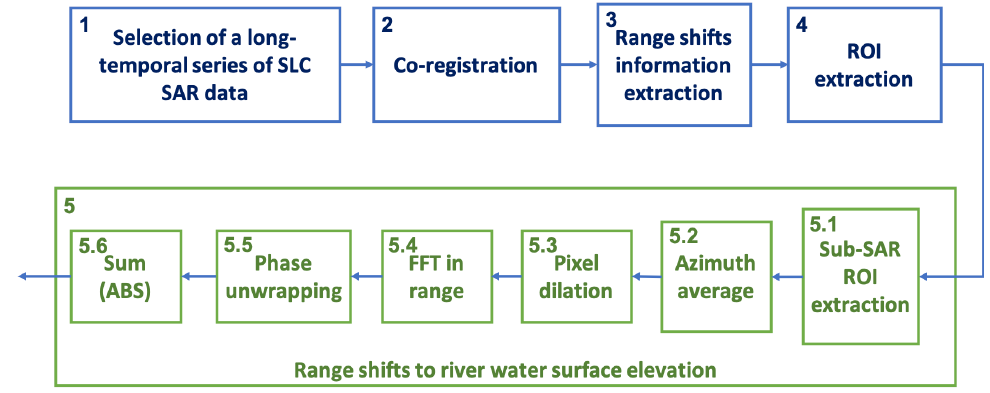
Figure 2. Flow chart of the main procedure to extract water level information from a temporal series of synthetic aperture radar (SAR)